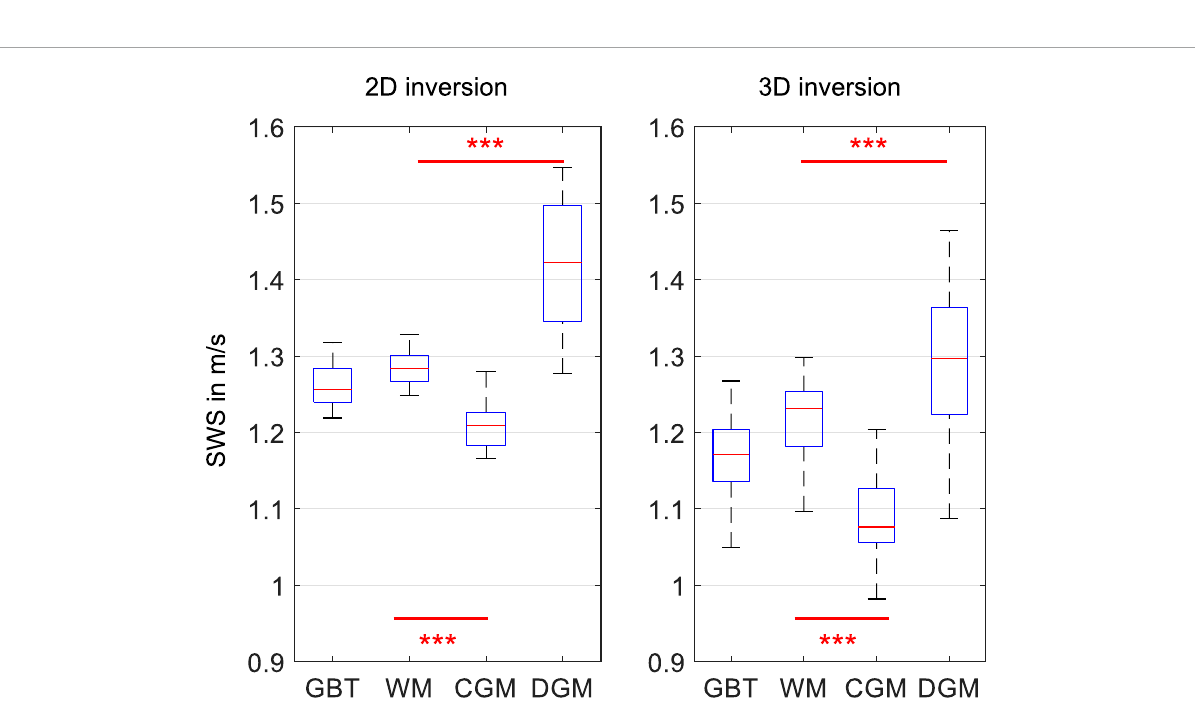
FIGURE 3 Group mean SWS values for 2D and 3D k -MDEV for global brain tissue (GBT), white matter (WM), cortical gray matter (CGM), and deep gray matter (DGM). Signi fi cance levels, indicated by asterisks, were determined from paired t-tests with Holm-Bonferroni correction between WM and CGM as well as WM and